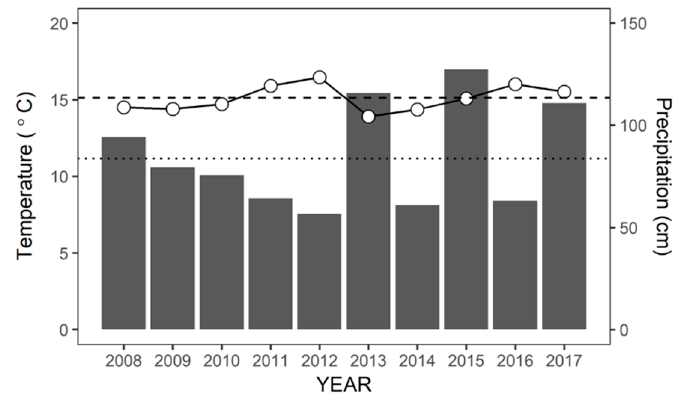
Figure 2. Annual average air temperature (line with open circles) and total precipitation (vertical bars). Long dash line indicates long term annual average temperature while dot line is for long term annual total precipitation.